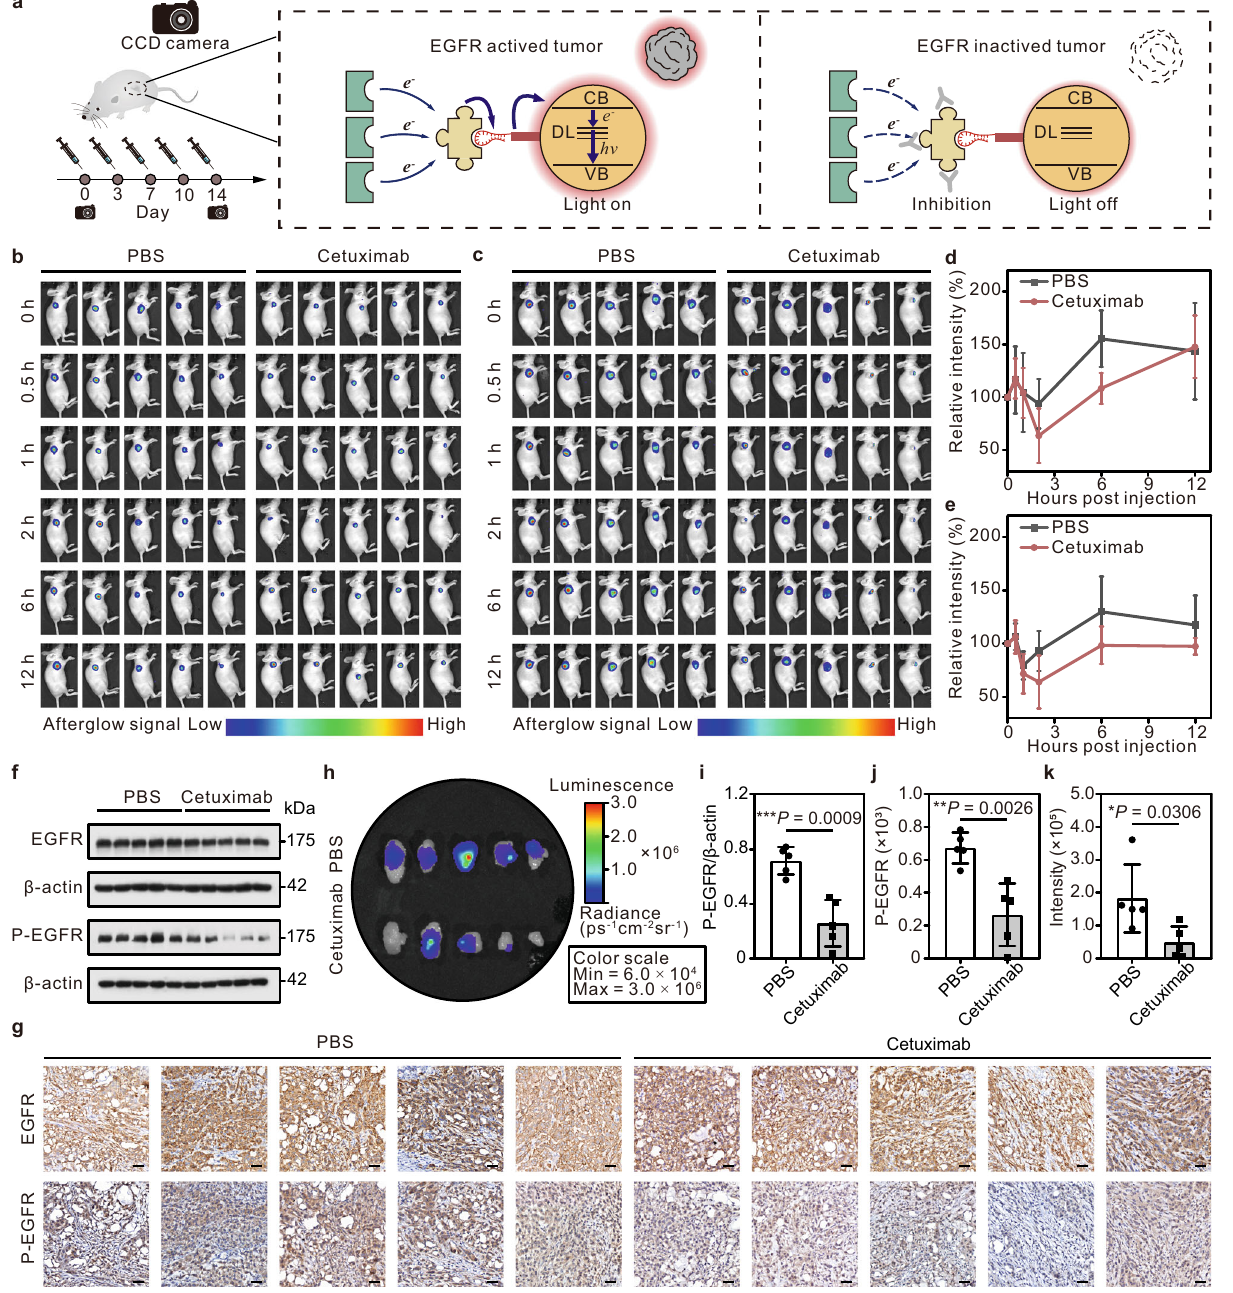
Fig. 5 EGFR signaling pathway-related electron transfer-triggered imaging in vivo during EGFR inhibition. a Schematic of electron transfer-triggered imaging of EGFR-inhibited mice with a single established A549 tumor. Mice with 50 mm 3 subcutaneous tumors were administered with PBS or cetuximab intraperitoneally twice per week. b , c Afterglow images of A549 xenograft mice treated with PBS or cetuximab at day 0 ( b ) and day 14 ( c ). The afterglow imaging was performed after 1.0 s of white light excitation. The afterglow signal intensities are displayed as color maps, color scale: ( b ) 3.5 × 10 5 – 3.0 × 10 6 , ( c ) 6.0 × 10 4 – 1.0 × 10 6 . d , e Corresponding quantitative data analysis of relative total radiance in tumor area of mice shown in b ( d ) and c ( e ). Data presented as mean values ± s.d., n = 5 mice. f Western blot analysis on expression of EGFR, P-EGFR, and β -catenin protein in tumors after the fi nal treatment. A representative image of fi ve biologically independent samples from each group is shown. g IHC analysis of tumor sections. EGFR and P-EGFR in the tumor sections of each group were observed by IHC analysis. Scale bar: 50 μ m. A representative image of fi ve biologically independent samples from each group is shown. h Afterglow images of harvested tumors from the tumor-bearing mice treated with PBS or cetuximab after 14 days treatment. Color scale: 6.0 × 10 4 – 3.0 × 10 6 . i , j Quantitative analysis of P-EGFR in tumor sections observed by western blot analysis ( i ) and IHC analysis ( j ). k Quantitative analysis of afterglow intensity in the tumor site. Data are presented as the mean values ± s.d.; unpaired two-tailed Student ’ s t -test; n = 5